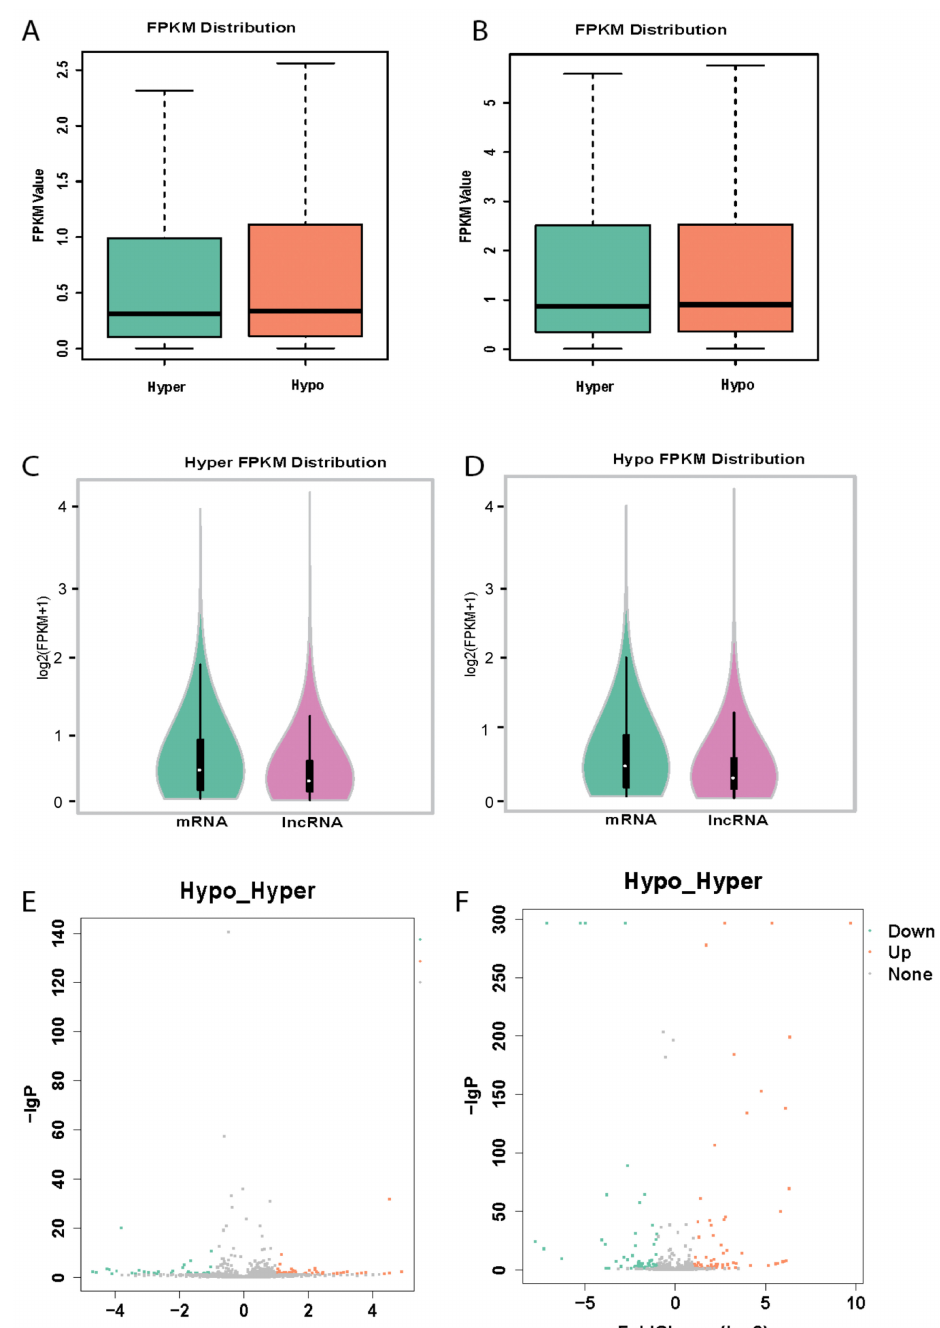
Figure 1. LncRNAs and their expression changes in platelets determined by the RNA-seq data set. ( A ) Box plot showing the distribution of the FPKM (fragments per kilobase of exon per million fragments mapped) values of known lncRNAs. ( B ) Box plot showing the distribution of the FPKM of novel lncRNAs. ( C ) Compare the mRNA and lncRNAs distribution in hyperreactive platelets. ( D ) Compare the mRNA and lncRNAs distribution in hyporeactive platelets. ( E ) Volcano plot of differentially expressed known lncRNAs between hyperreactive and hyporeactive platelets Down or up mean lower or overexpression in hyporeactive platelets compared to hyperreactive platelets (Hypo vs. Hyper). ( F ) Volcano plot of differentially expressed novel lncRNAs (Hypo vs. Hyper). Red dots represent up expressed RNAs and green dots represent down expressed RNAs with at least two-fold change and corrected p -value <0.05. Orange and cyan dots indicate significantly upregulated and downregulated lncRNAs,